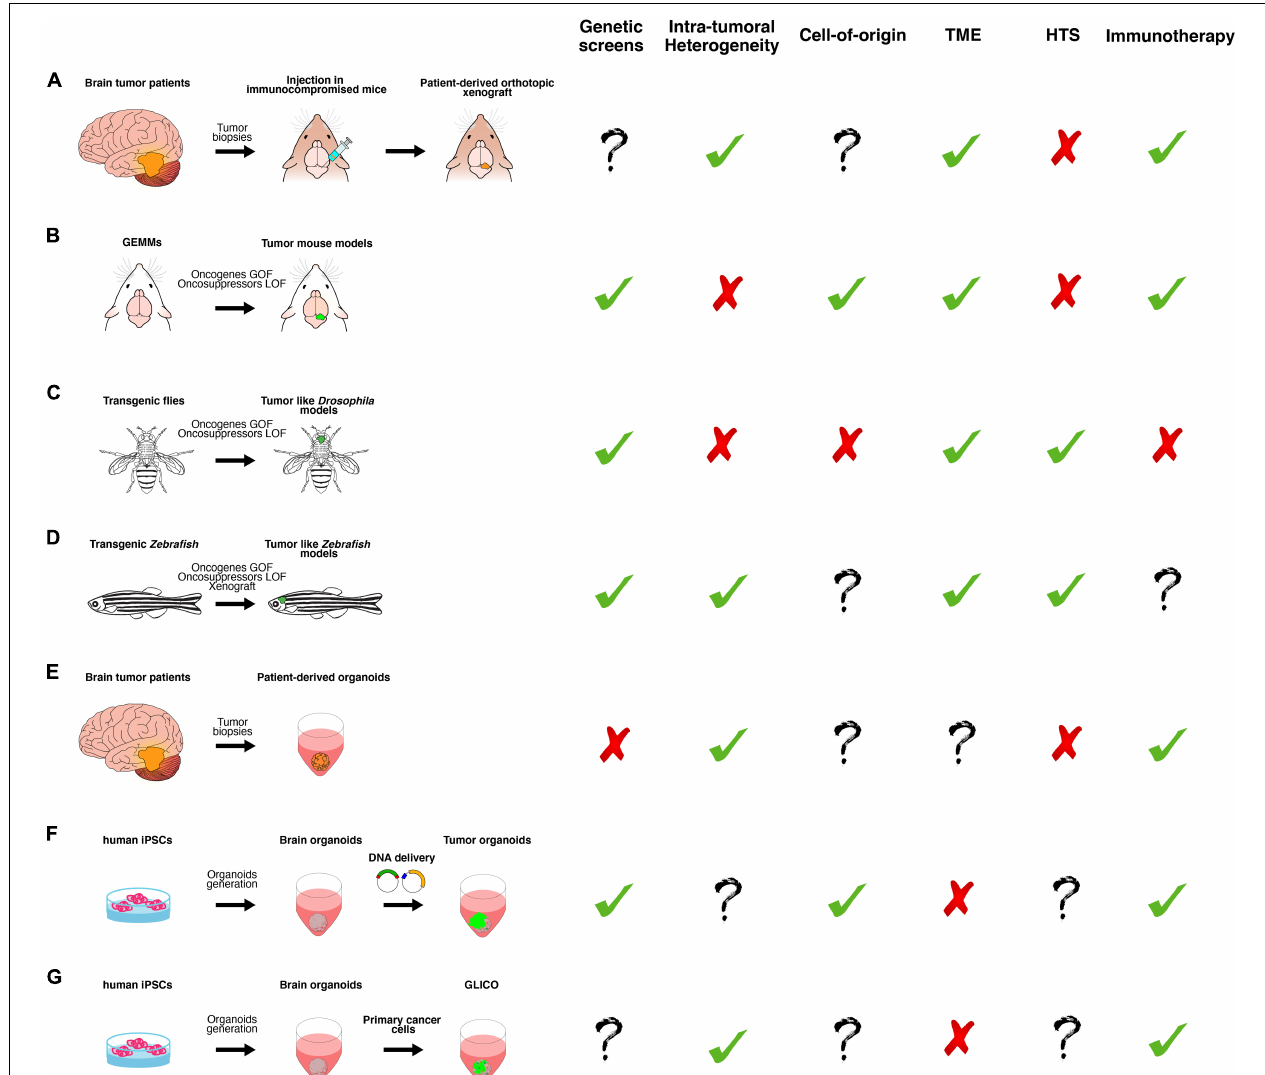
FIGURE 2 | A schematic overview of the main classes of in vitro and in vivo preclinical brain cancer models and their relative applications. (A) Brain cancer tissue surgically resected from patients is directly transplanted in the brain of immunocompromised mice, producing patient-derived orthotopic xenograft models (PDOX). (B) Genetically engineered mouse models (GEMMs) in which the tumor formation is induced by gain or loss of function of oncogenes or oncosuppressors, respectively. They can be generated by breeding animals that carry germline mutations or injecting virus or plasmids, harboring the gene of interest. (C) Transgenic flies in which the tumor-like phenotype is determined by gain or loss of function of oncogenes or oncosuppressors, respectively, in a time- and tissue-specific manner. (D) Transgenic Zebrafish in which the tumor-like phenotype is determined by gain or loss of function of oncogenes or oncosuppressors, respectively, in a time- and tissue-specific manner. Xenotransplantation of human glioma cells in zebrafish. (E) Brain cancer tissue surgically resected from patients is directly cultured in 3D culture as patient-derived organoids (PDO). (F) Tumor organoids can be generated by gain or loss of function of oncogenes or oncosuppressors, respectively, in cerebral or cerebellar organoids derived from human-induced pluripotent stem cells (iPSCs). (G) GLICO can be generated by co-culturing primary cancer cells with cerebral organoids. Based on published works, we summarized the possible usages of each class of the models in the following applications: genetic screens (i.e., testing the function of new genes in tumor formation, progression and aggressiveness); investigation of intra-tumoral heterogeneity, cell of origin and tumor microenvironment (TME); high-throughput screening (HTS) of new chemotherapeutic drugs and, finally, for testing new immunotherapy approaches.